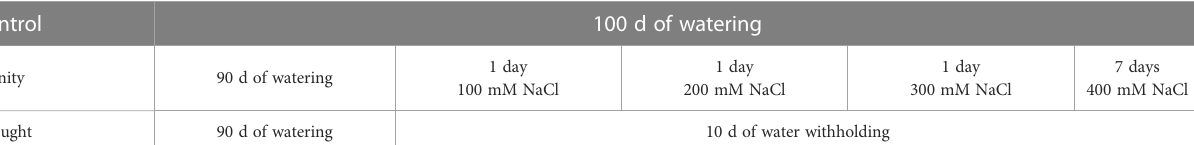
TABLE 1 Method used for stress